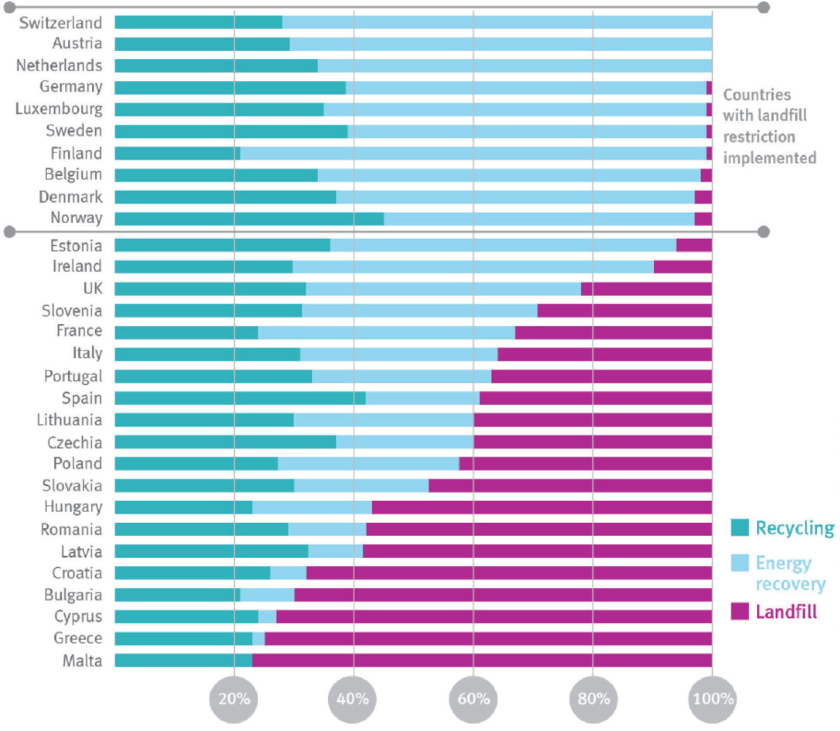
Figure 1. Plastic post-consumer waste rates of recycling, energy recovery, and landfill per country in 2018. Source: Plastics Europe. Plastics—the Facts 2019. [2] 2018. Source: Plastics Europe. Plastics—the Facts 2019